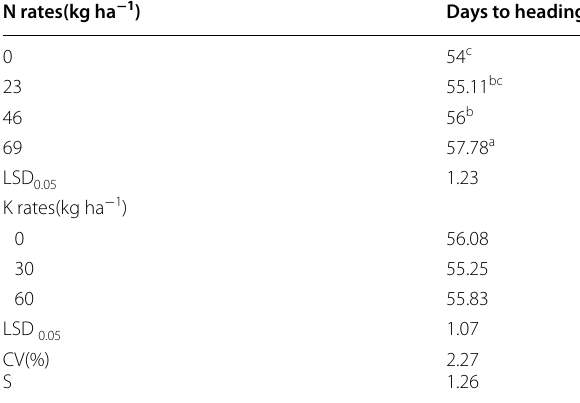
Table 2 Days to heading as affected by the interaction of N and K fertilizer